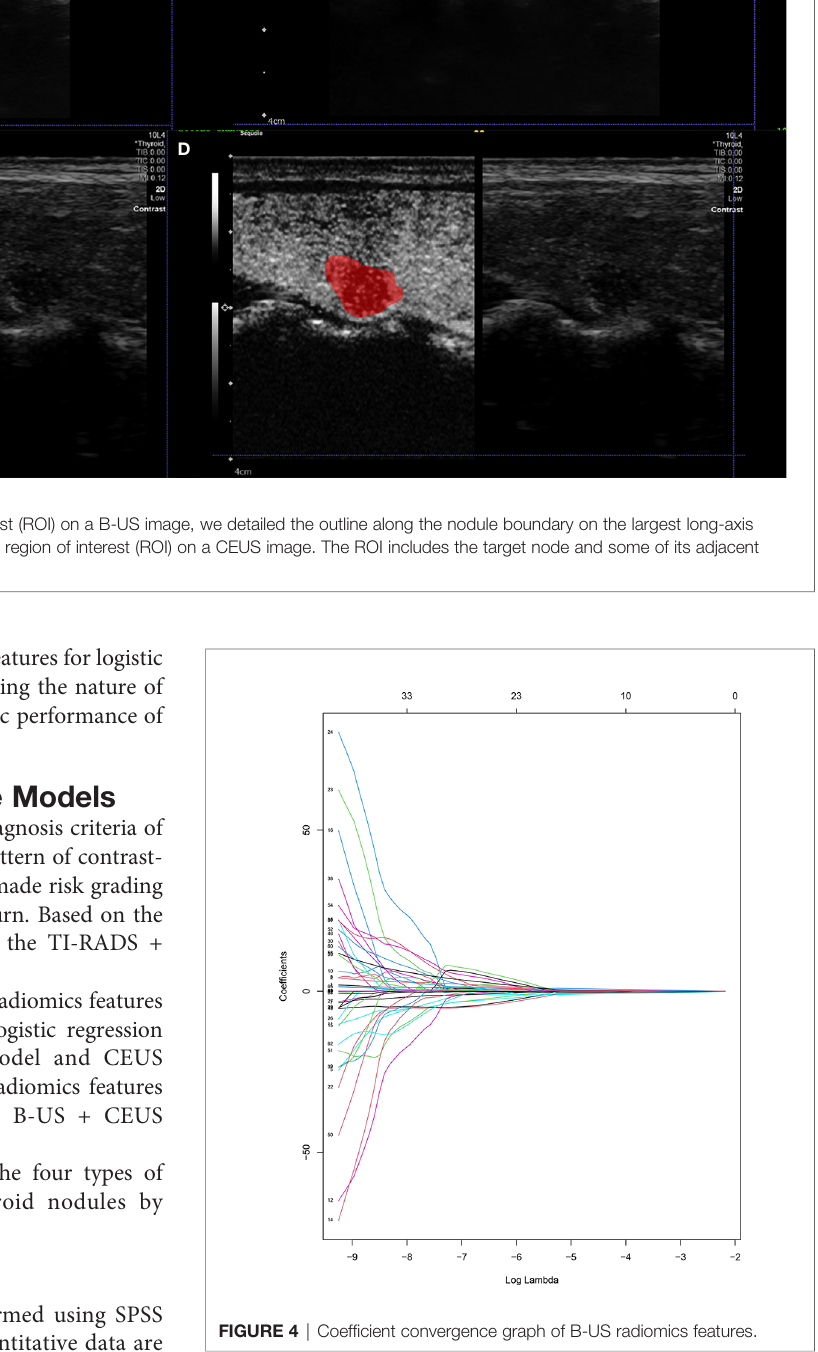
FIGURE 4 | Coef fi cient convergence graph of B-US radiomics